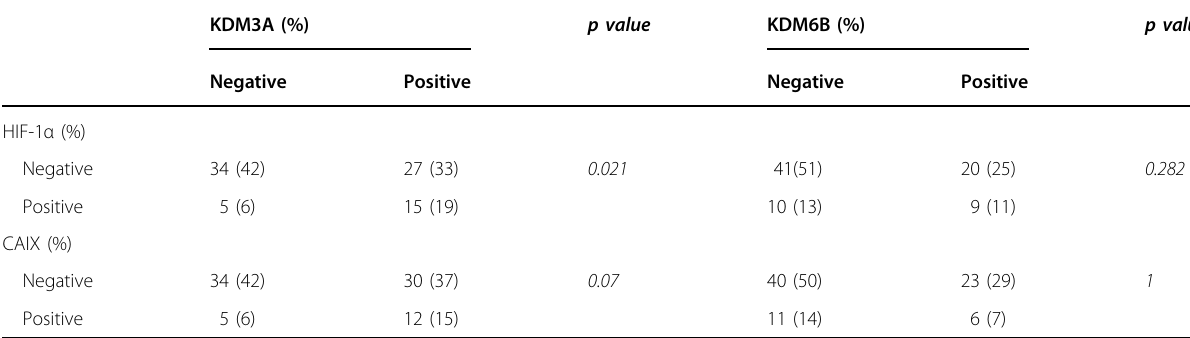
Table 2 KDMs and hypoxic markers association in tissue